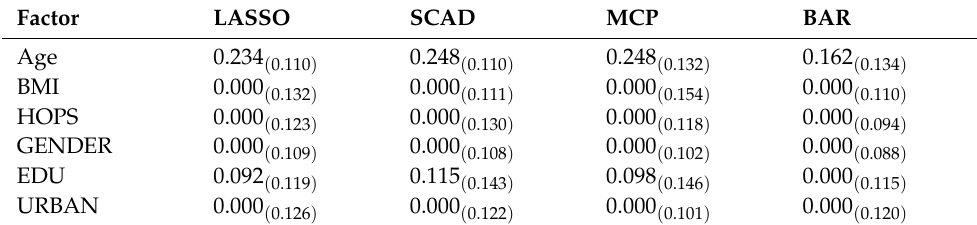
Table 7. Analysis results of children’s mortality data based on choice (I).